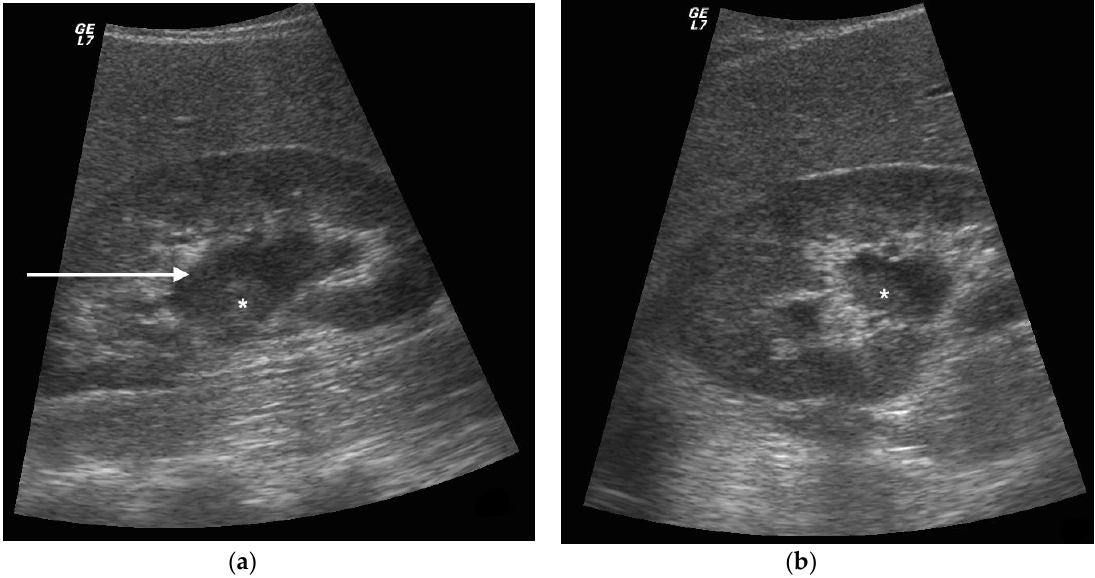
Figure 4. A 42 years old septic female patient. US longitudinal view ( a , b ) of the right kidney showing low/mild-grade hydronephrosis (white arrow) with sharply defined urine debris level (*).